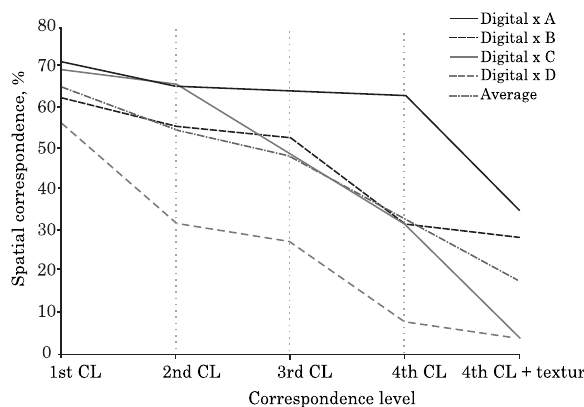
Figure 7. Spatial correspondence between conventional soil maps and the